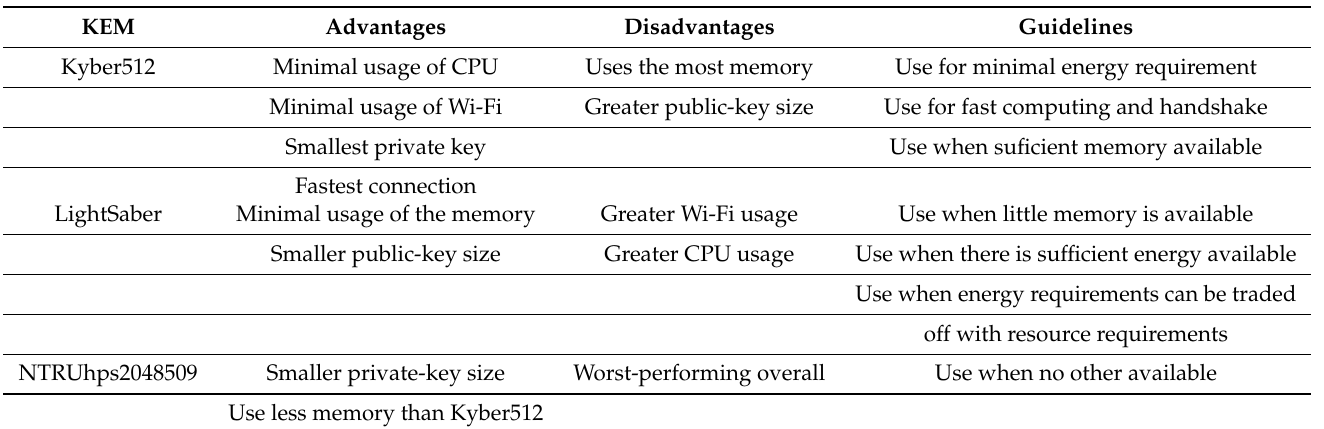
Table 14. General guidelines for selecting the appropiate post-quantum cryptosystem for resource- constrained devices, according to its performance and